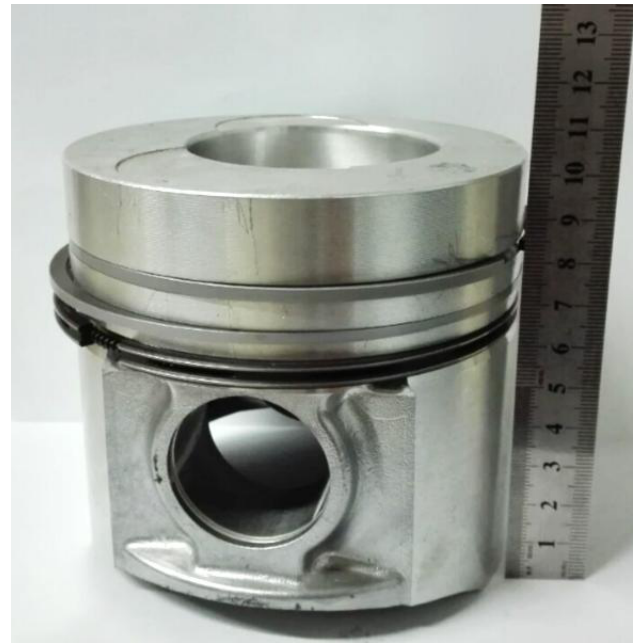
Figure 16. Configuration of piston rings.